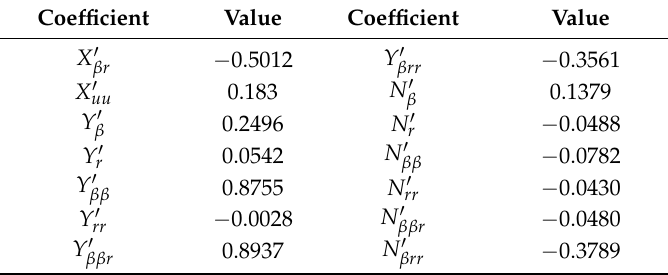
Table 2. Ship hydrodynamic